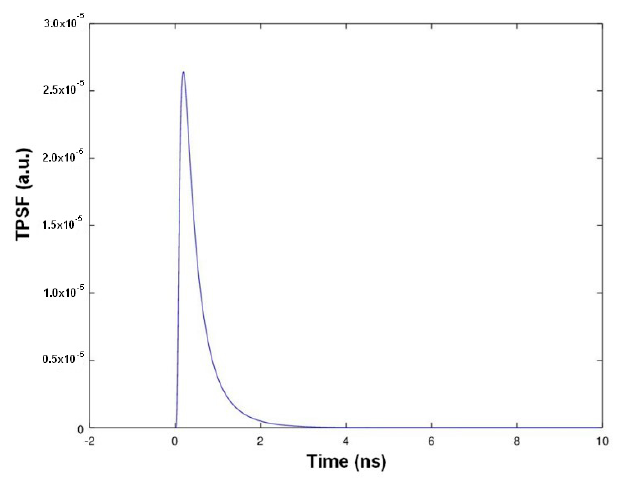
Figure 7. Theoretical number of collected photons as a function of time.